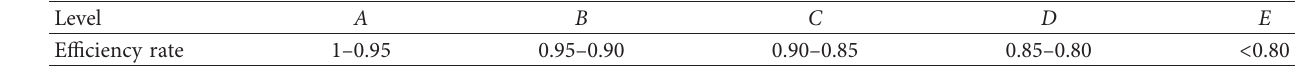
Table 4: Levels of system efficiency